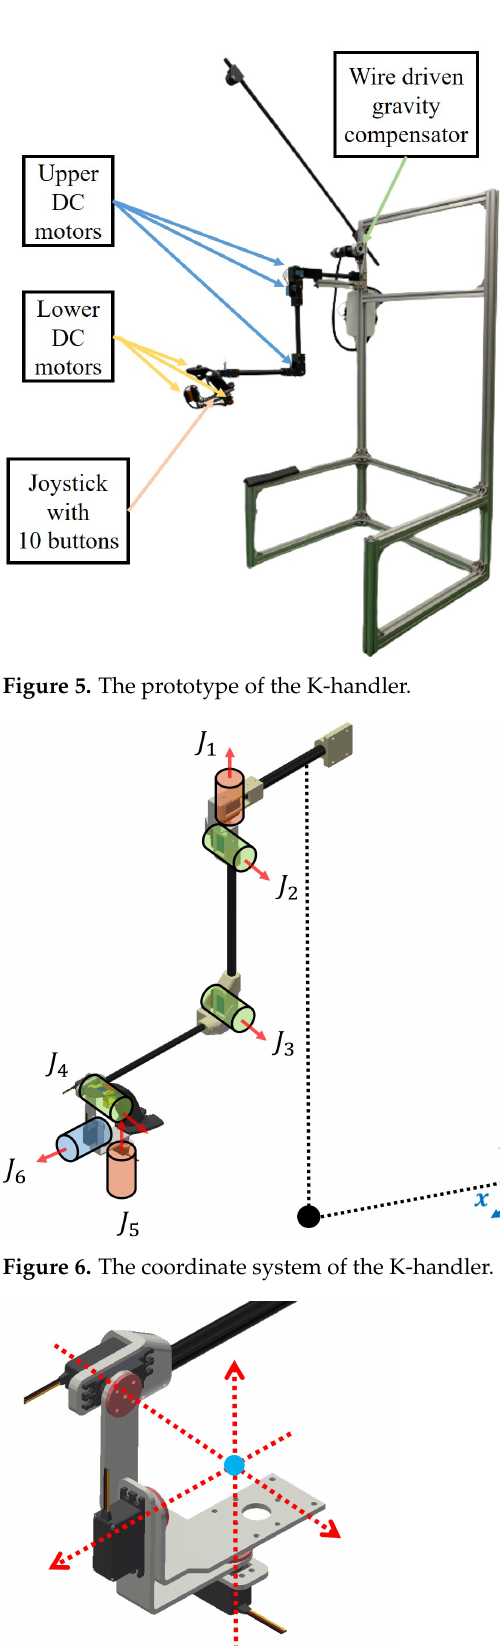
Figure 7. The wrist orientations intersect at one